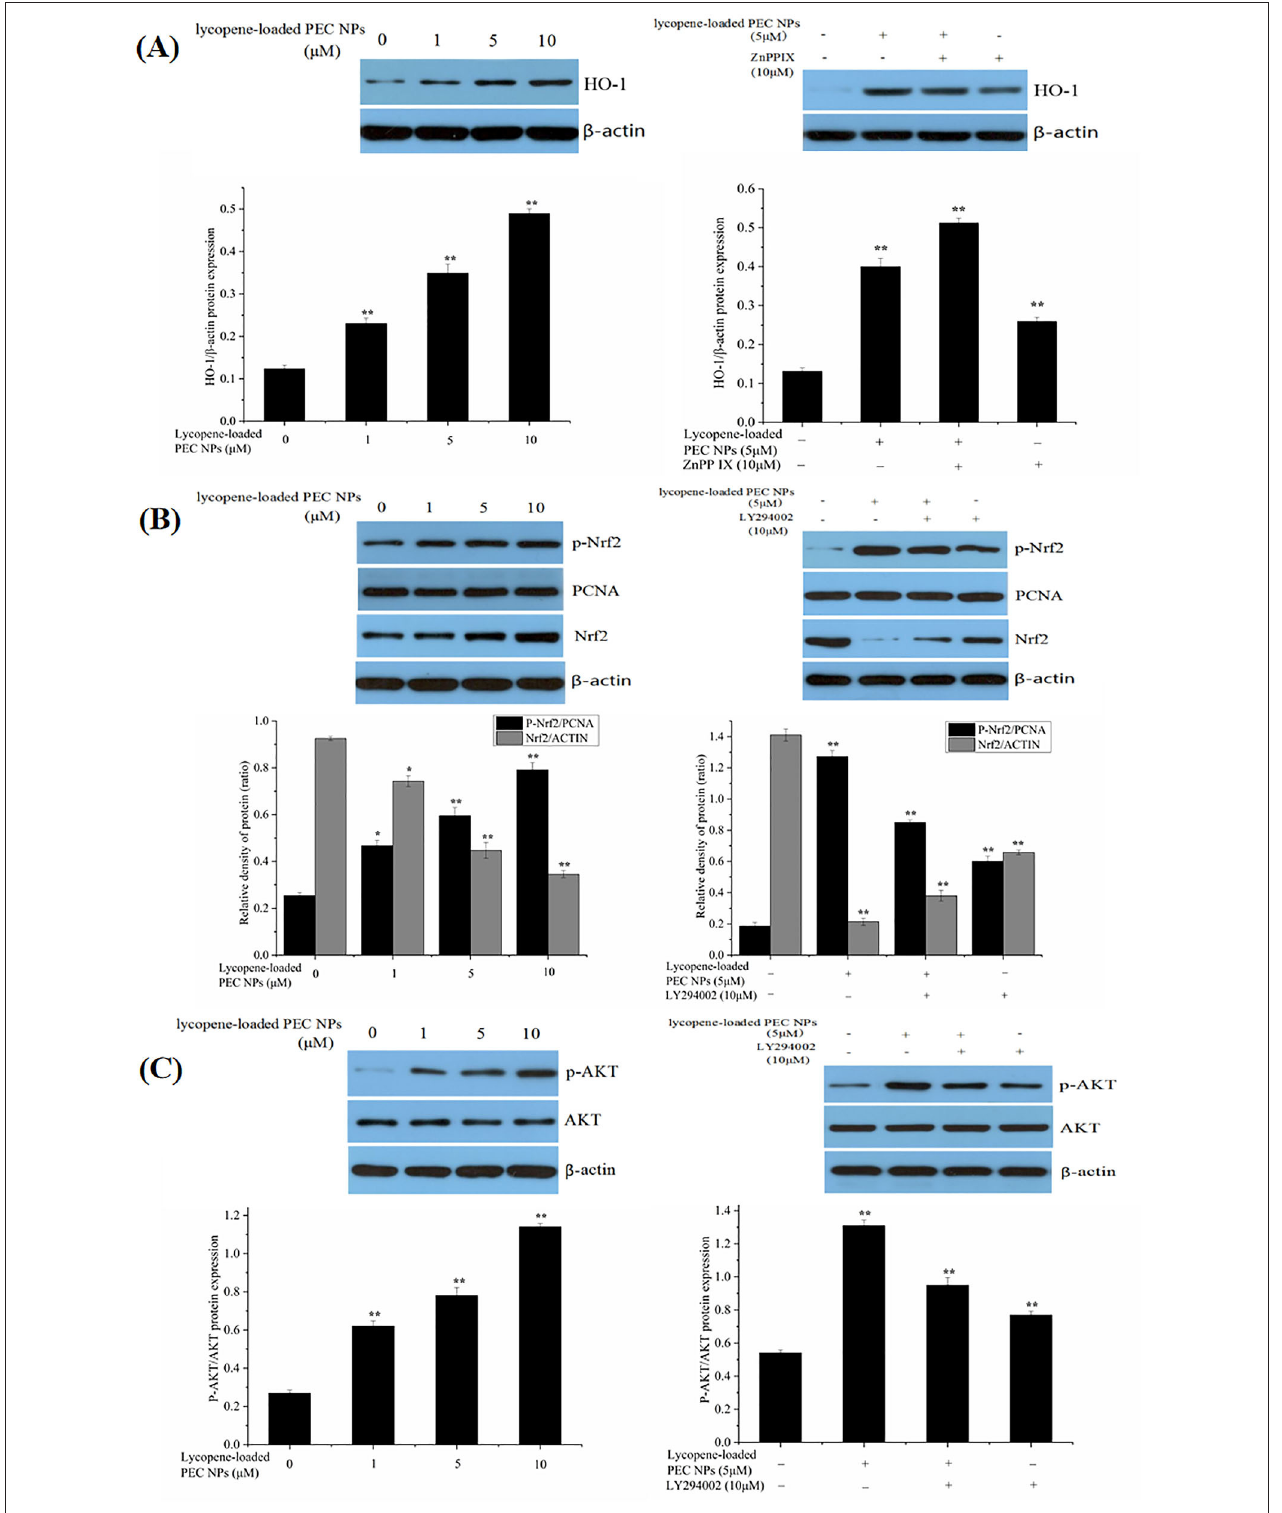
FIGURE 12 | Effect of lycopene-loaded PEC NPs on protein expression of HO-1, p-Nrf2, Nrf2, p-AKT, and AKT. (A) Cells were treated with lycopene-loaded PEC NPs (0, 1, 5, and 10 µ mol/L) for 24h, and then protein expression of HO-1 was determined by western blot analysis (Left); Cells were pretreated with 10 µ M ZnPP-IX for 1h prior to incubation with or without 5 µ mol/L lycopene-loaded PEC NPs for 24h and then protein expression of HO-1 was determined by western blot